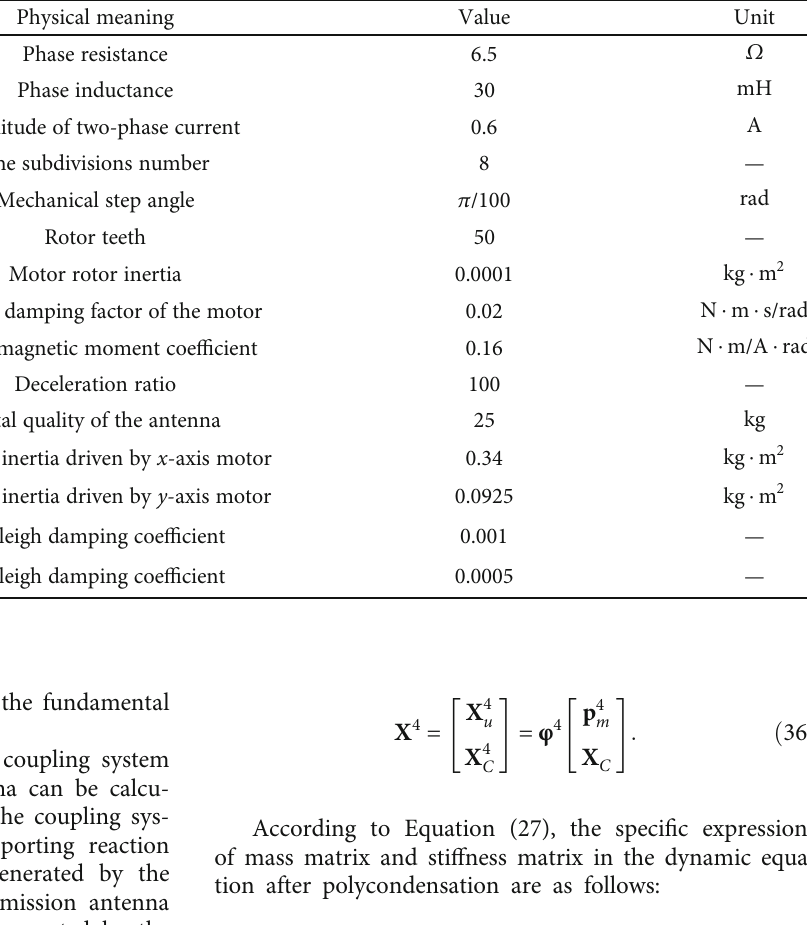
Figure 3: Simulation model of data transmission antenna. Table 2: Simulation